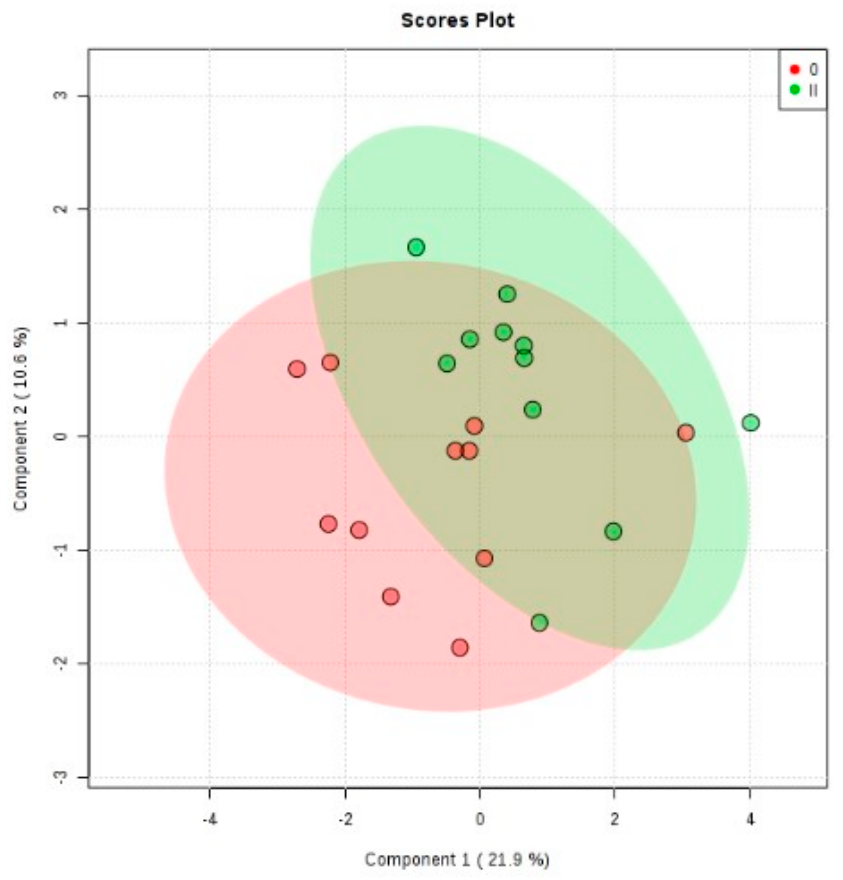
Figure 3. 2D score plots for PLS-DA analysis for groups MDD2 (code II) vs. MDD1 (Code 0). Table 4. Metabolites levels with VIP > 0.2 on all components in comparison group MDD2 vs. MDD1 p - and FC values.